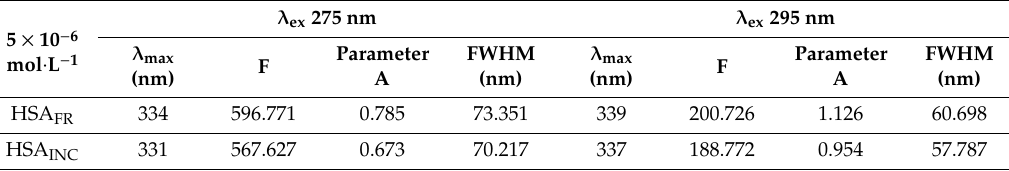
Table 2. Fluorescence of unmodified human serum albumin (HSA FR ) and incubated human